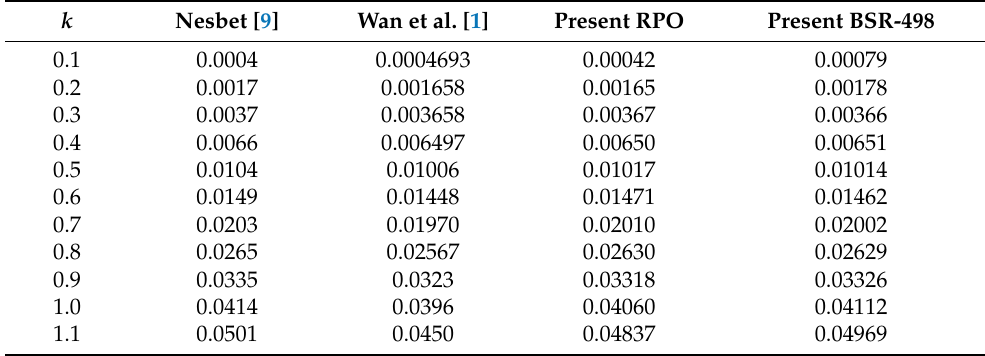
Table 3. D -wave phaseshift as a function of linear momentum k for infinite nuclear